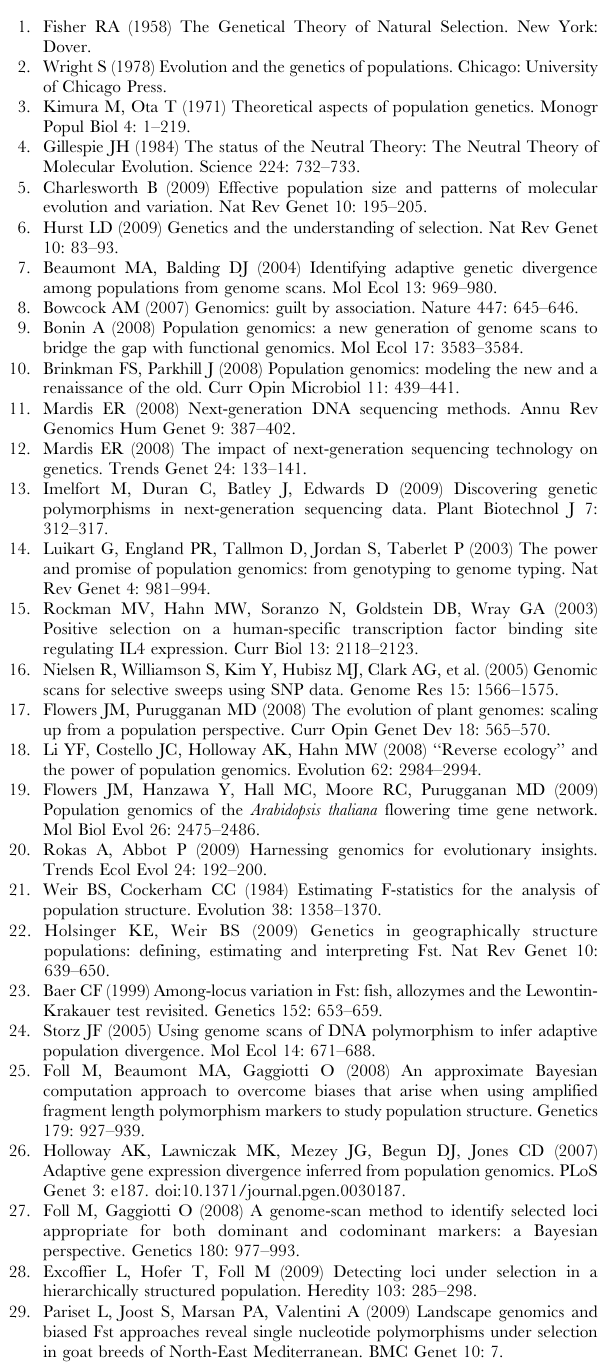
Table S3 Candidate genes related to skeletal morphology and osmoregulation in additional regions of differentiation on Linkage Groups IV, VII, and